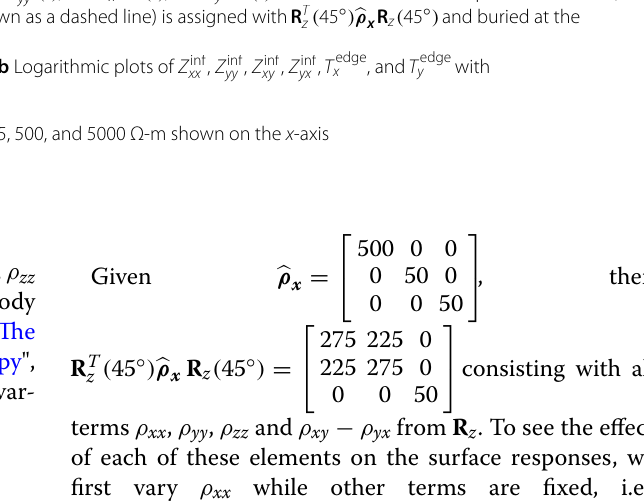
ρ x R z ( 45 ◦ ) and buried at the (cid:31)